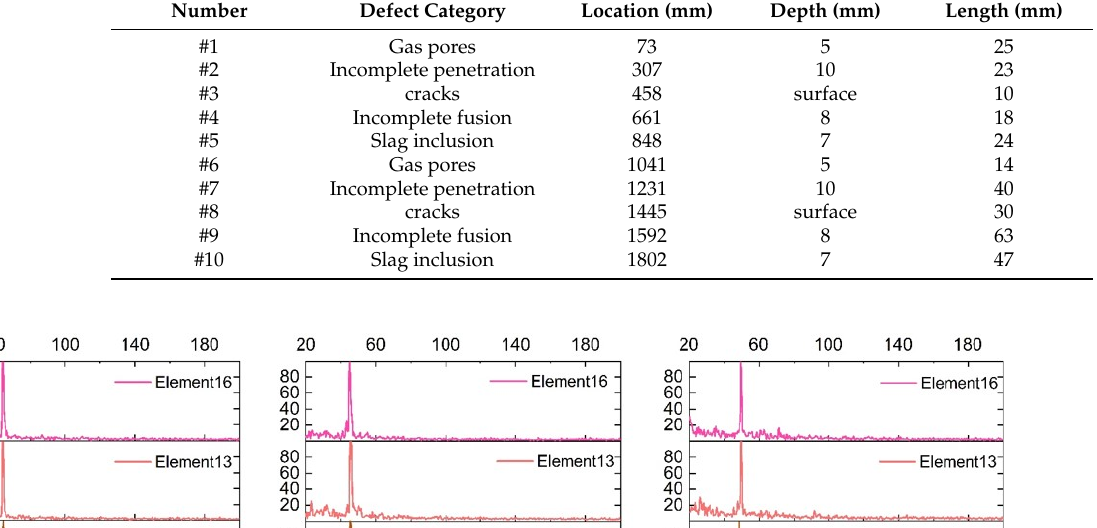
Table 1. Structural sizes of girth weld defects in the pipeline test sample.